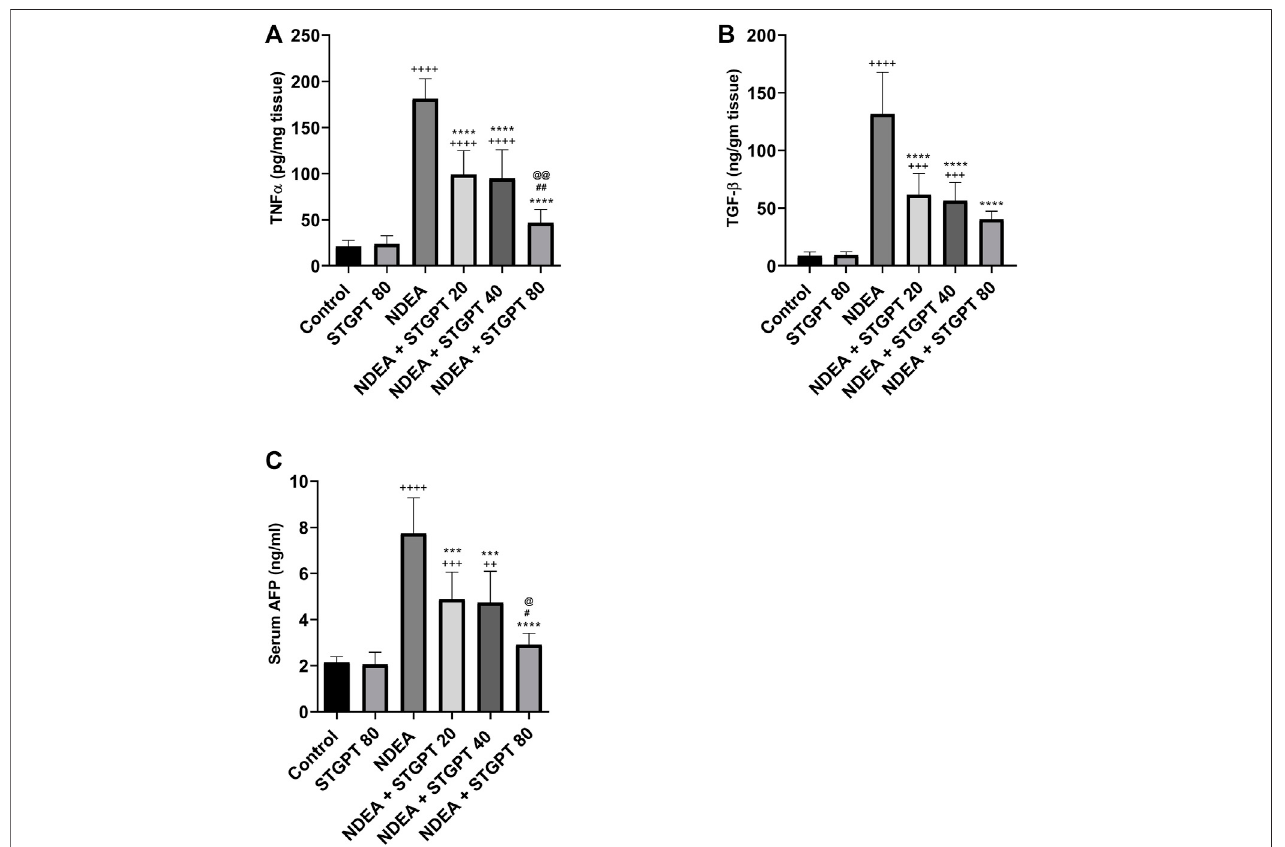
FIGURE4| Effect ofSTGPT(20, 40and80 mg/kg)on TNF- α (A) ;TGF- β (B) ;and AFP (C) inmicewithNDEA-induced HCC. Dataarepresented asthemean ± SD (n (cid:1) 6). ++ p < 0.01 vs Control group, +++ p < 0.001 vs Control group, ++++ p < 0.0001 vs Control group, *** p < 0.001 vs NDEAgroup, **** p < 0.0001 vs NDEA group, # p < 0.05 vs STGPT 20 group, ## p < 0.01 vs STGPT 20 group, @ p < 0.05 vs STGPT 40 group, @@ p < 0.01 vs STGPT 40 group. Control, normal control group received the vehicle;STGPT80,normalgroupreceivedsitagliptin(80 mg/kg);NDEA,NDEA-induced HCCgroupreceivedthevehicle;NDEA+STGPT20,NDEA-inducedHCC group treated with sitagliptin (20 mg/kg); NDEA + STGPT 40, NDEA-induced HCC group treated with sitagliptin (40 mg/kg); NDEA + STGPT 80, NDEA-induced HCC group treated with sitagliptin (80 mg/kg).